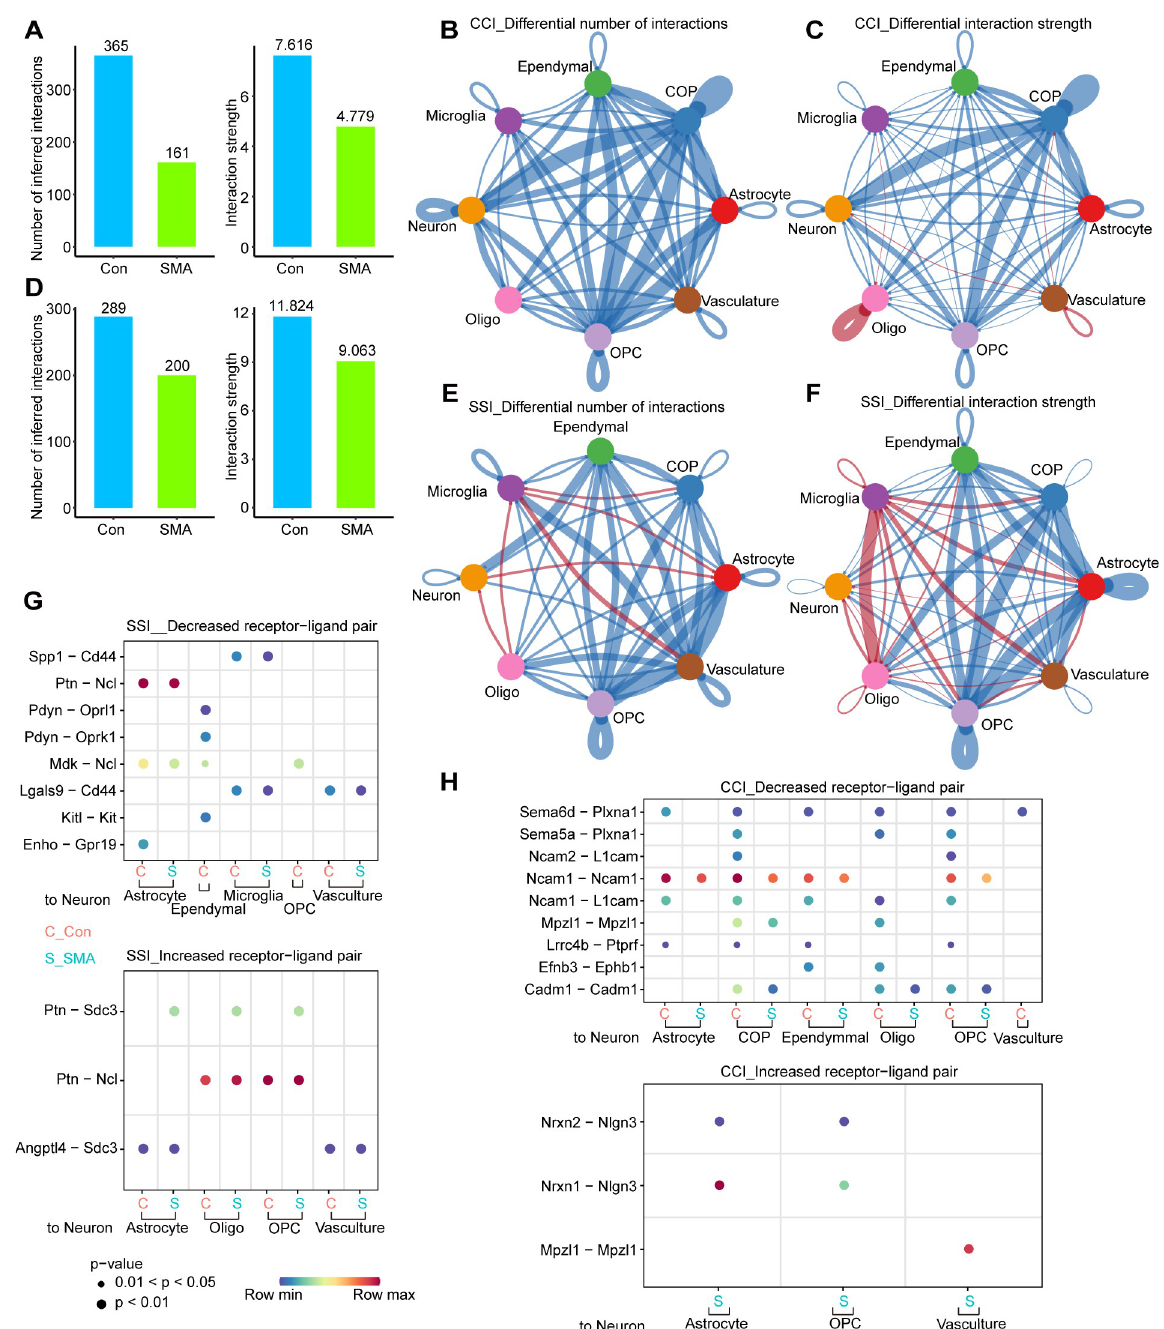
Fig 3. Cell-cell communications are reduced in the spinal cord of SMA mice. (A) Overall number and strength of cell-cell communications based on CCIs. (B, C) Differences in the (B) number and (C) strength of CCIs communications of various cell types between SMA mice and control mice. The blue line indicates decreased communications, and the red line indicates increased communications. The thicker the line, the greater the difference. (D) Overall number and strength of cell-cell communications based on SSIs. (E, F) Differences in the number (E) and strength (F) of SSIs communications of various cell types between SMA and control mice. The blue line indicates decreased communications, and the red line indicates increased communications. The thicker the line, the greater the difference. (G, H) Receptor–ligand pairs that differ significantly between SMA and controls based on SSIs (G) and CCIs